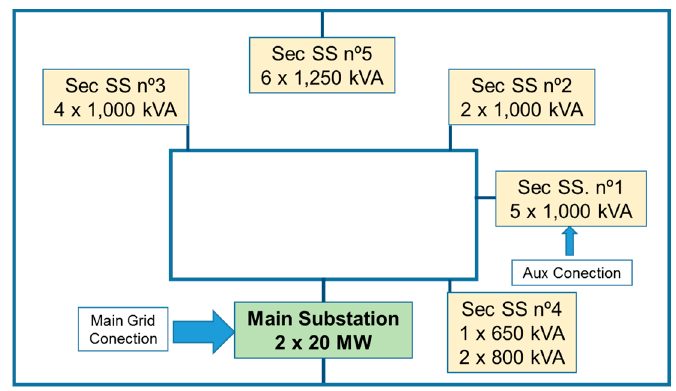
Figure 1. Schematic of the main substation and Sec SSs of the Hospital.